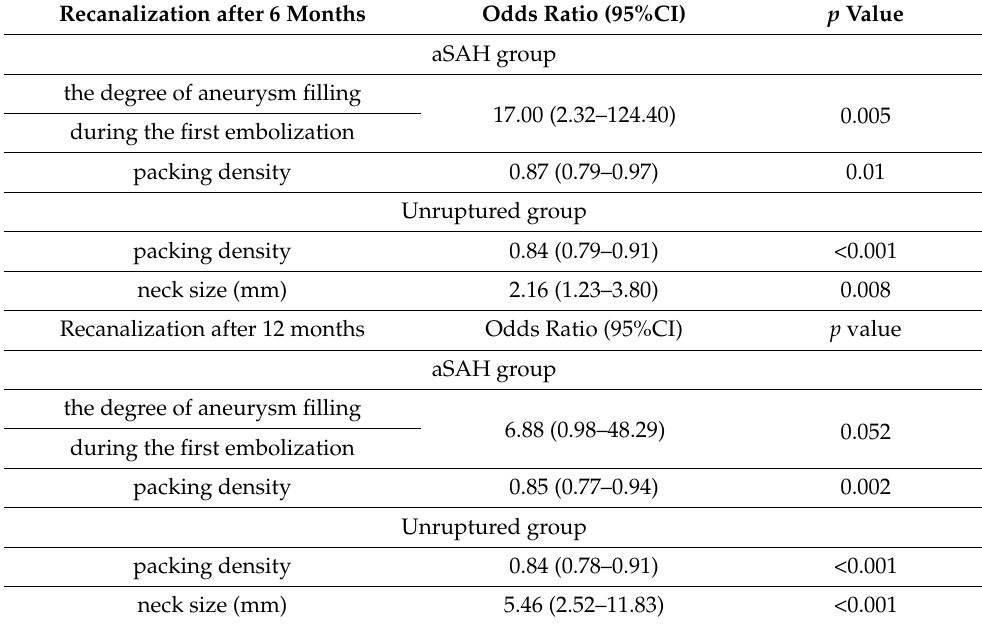
Table 4. Multivariable analysis